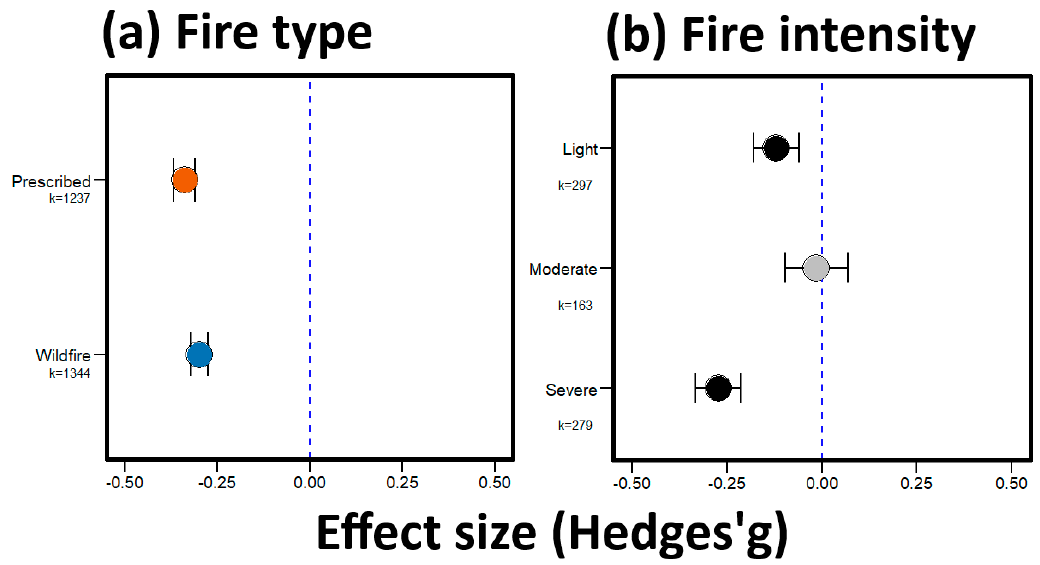
Figure 6. Overall effect of fire regimes ( a ) prescribed vs. wildfire ( b ) Fire intensity. The x-axis shows overall effect size (Hedges’ g). k is the number of observations included in each analysis. Circles denote the Hedges’ g value and lines denote the 95% confidence intervals. In ( b ), Black circles are significant effects whilst grey circles show no significant effects.